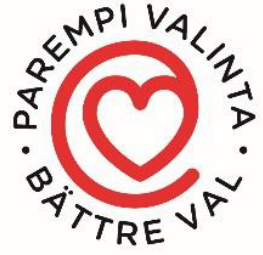
Figure 2. The Heart symbol with the text “better choice” in Finnish and Swedish. Image reproduced with the permission of the Finnish Heart Association.